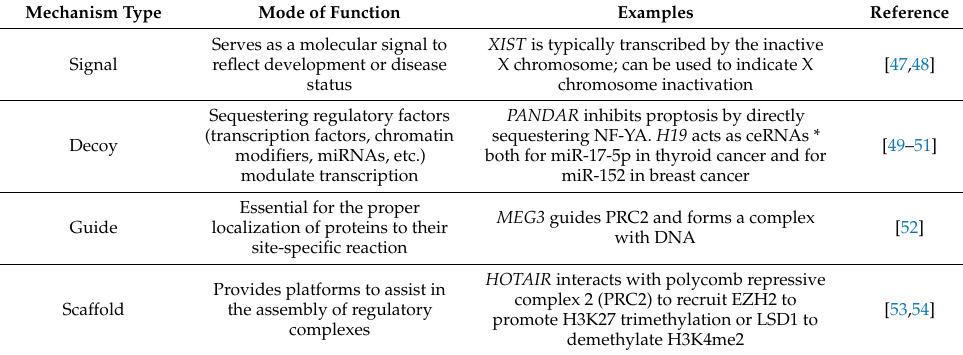
Table 3. Molecular functions of